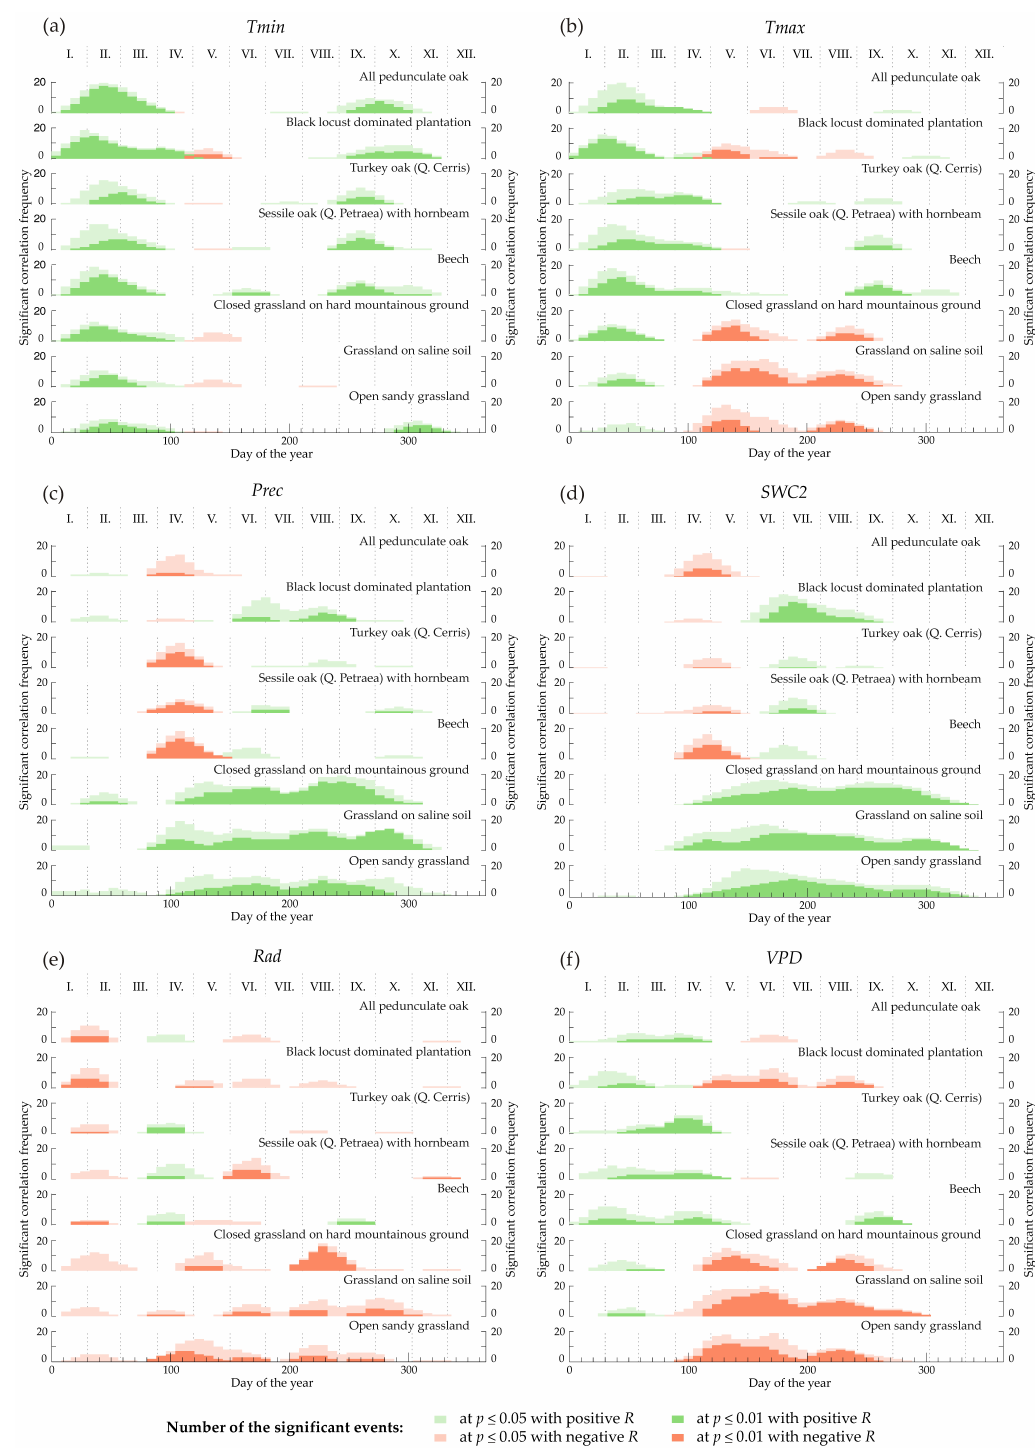
Figure 6. Critical climate periods within the year, when Tmin ( a ), Tmax ( b ), Prec ( c ), SWC2 ( d ), Rad ( e ), and VPD ( f ) significantly influenced the state of the vegetation (NDVI). The significant correlation frequency (i.e., the numbers of the instances, maximum 20; five time lags & four 8-day periods; see methods) associated with significant R is shown for all 8-day periods during the year. Periods corresponding to positive R -values are indicated with green, while those with negative R -values are indicated with red color. Significant values at p ≤ 0.01 are shown in darker shades, while those with p ≤ 0.05 are shown in lighter